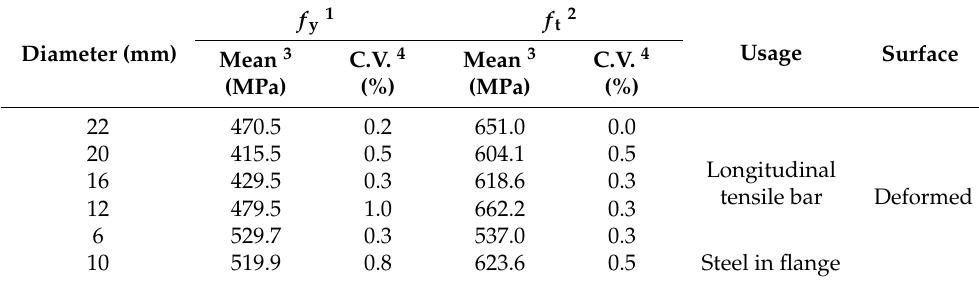
Table 5. Tensile test results of steel bars.